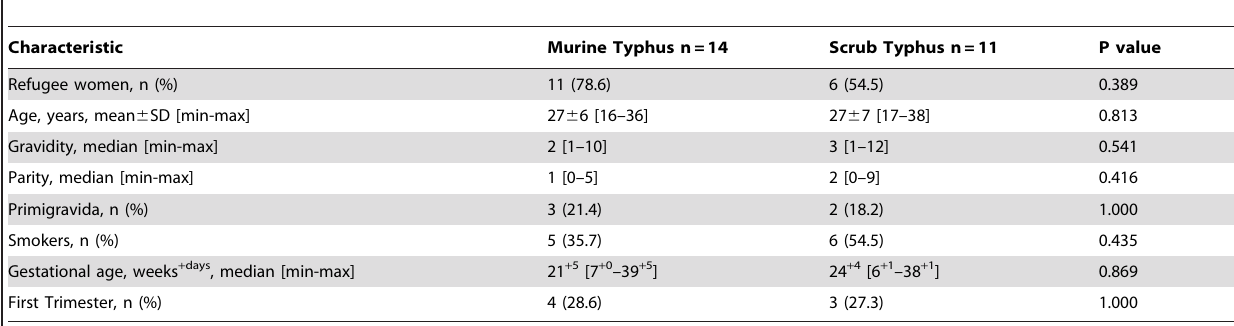
Table 1. SMRU fever cohort women baseline demographic and obstetric characteristics according to the diagnostic group.